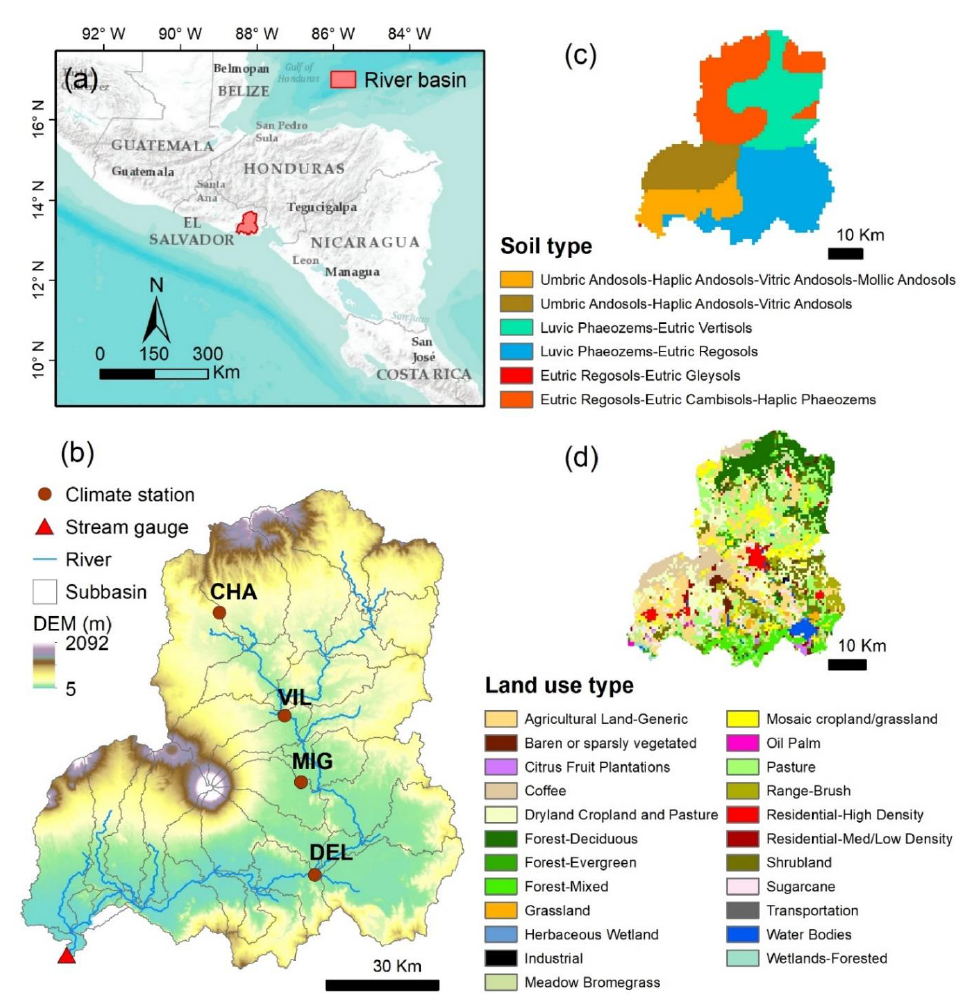
Figure 1. The study area location: ( a ) location of the Grande San Miguel river basin in Central America, ( b ) digital elevation model (DEM), sub-basins, and river stream delineation in the Grande San Miguel river basin, ( c ) soil map, and ( d ) land-use map.